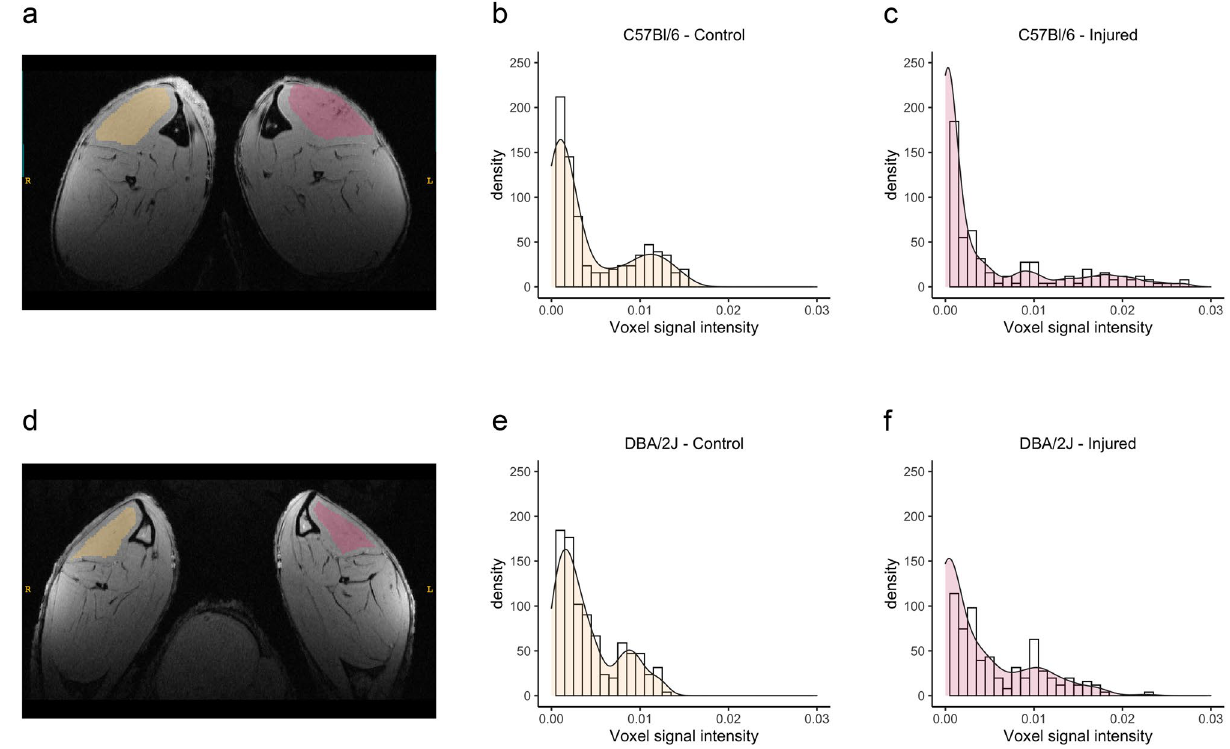
Figure 5. Altered signal intensity distribution in high-resolution images of injured muscles. T1-weighted high- resolution images were acquired with in-plane resolution of 50 μm and slice thickness of 200 μm. Representative high-resolution image of a C57Bl/6 ( a ) and a DBA/2J ( d ) mouse, showing the ROIs drawn over injured (red) and control (yellow) tibialis cranialis and the histograms of signal intensity in the ROIs: ( b )